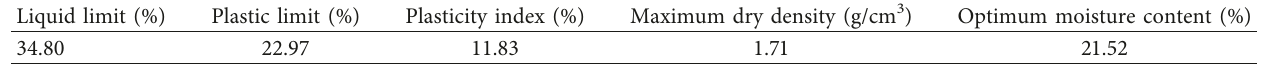
Table 1: Physical properties of silty clay.